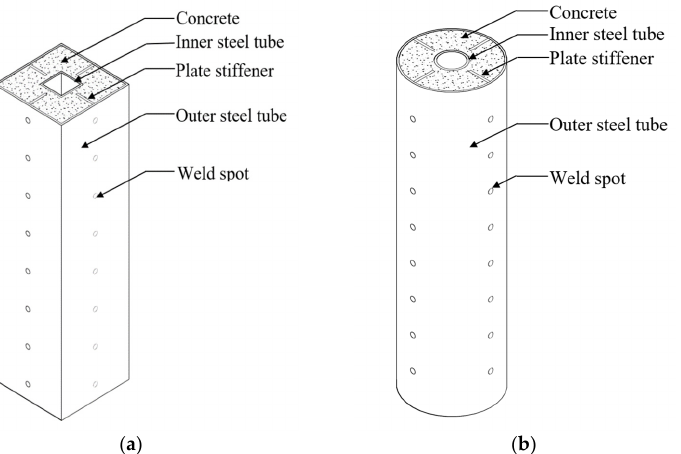
Figure 4. The side-view of the test specimens. ( a ) Typical square CFDST with plate stiffeners. ( b ) Typical circular CFDST with plate stiffeners.